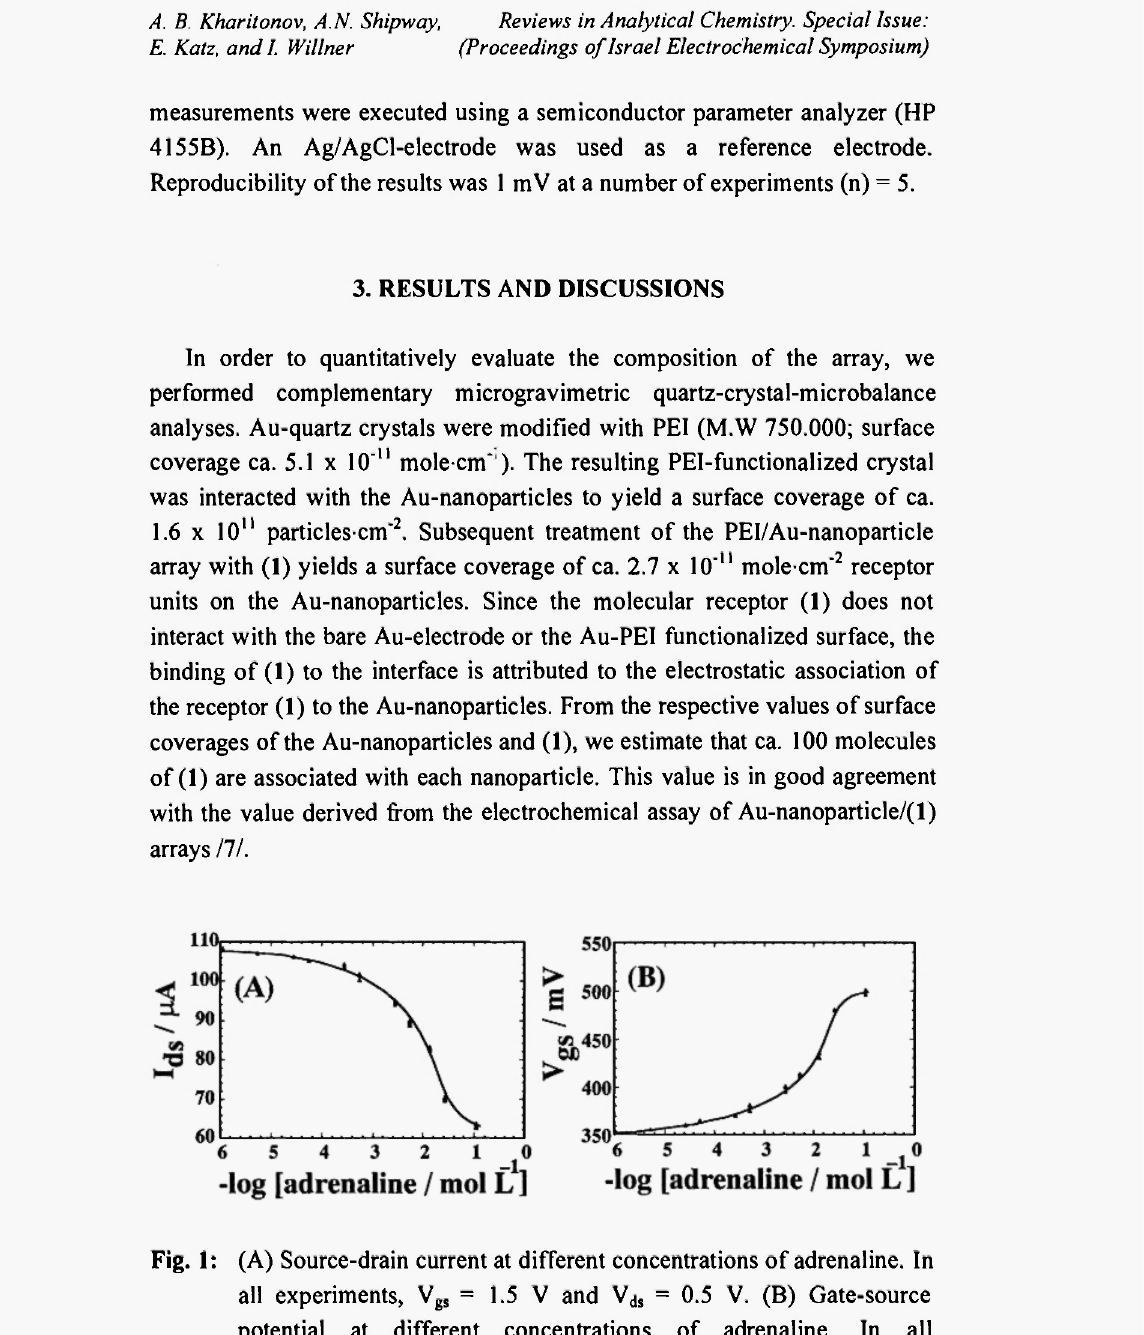
Fig. 1: (A) Source-drain current at different concentrations of adrenaline. In all experiments, V gs = 1.5 V and V ds = 0.5 V. (B) Gate-source potential at different concentrations of adrenaline. In all experiments, I ds = 100 μΑ and V ds = 0.5 V.